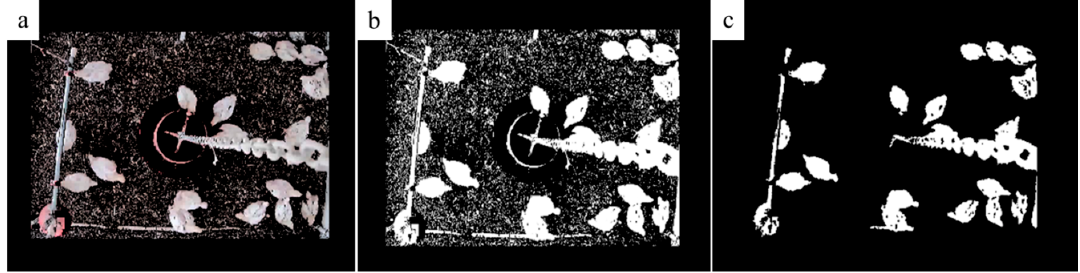
Figure 4. The image processing steps. ( a ) Nontarget area removal; ( b ) Generation of binary image; ( c ) Morphological corrosion operation and background removal.